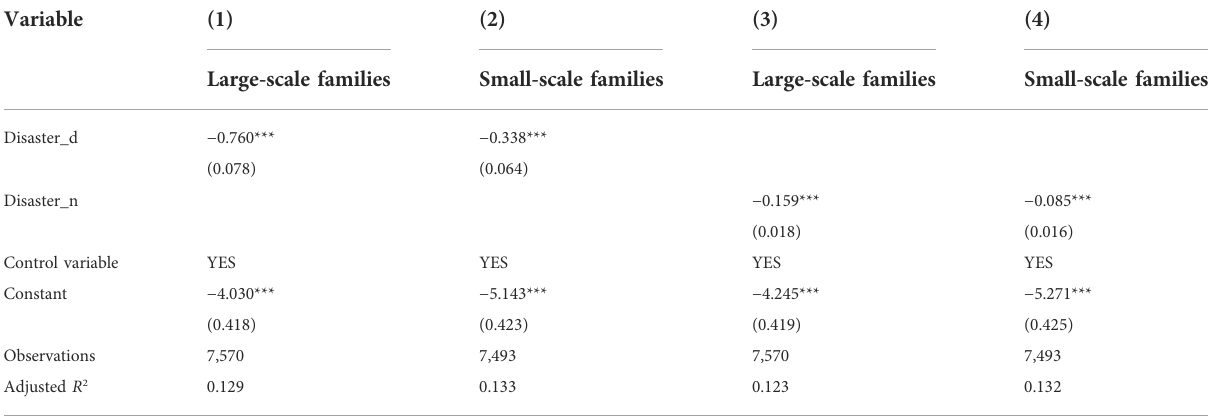
TABLE 8 Heterogeneity in the impact of natural disasters on households of different